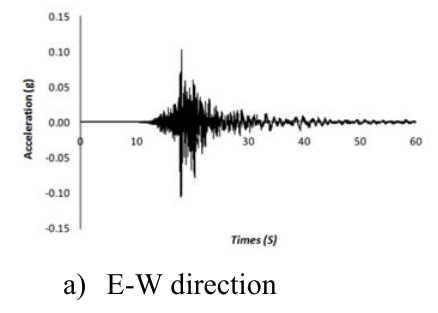
Fig. 3. Acceleration records of the Gediz Fig. 2. Acceleration records of the Gediz Station. 3